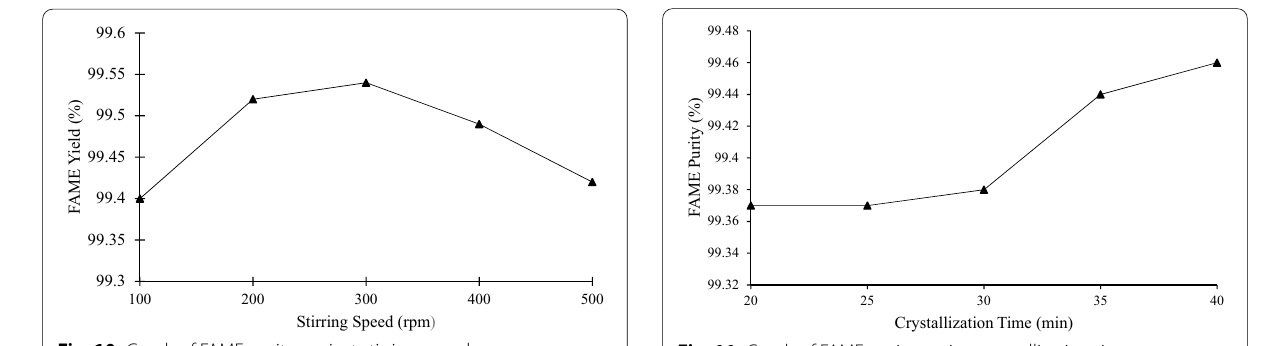
Fig. 10 Graph of FAME purity against stirring speed